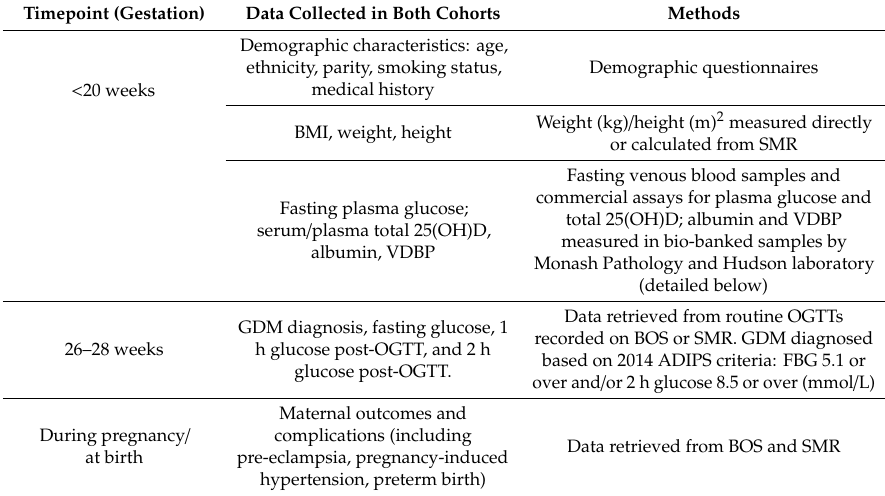
Data retrieved from BOS and